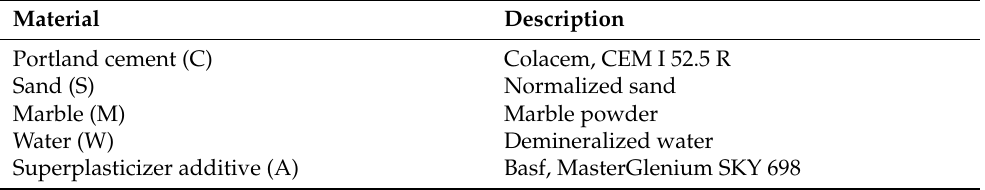
Table 1. List of materials used for making the specimens analyzed in this work.